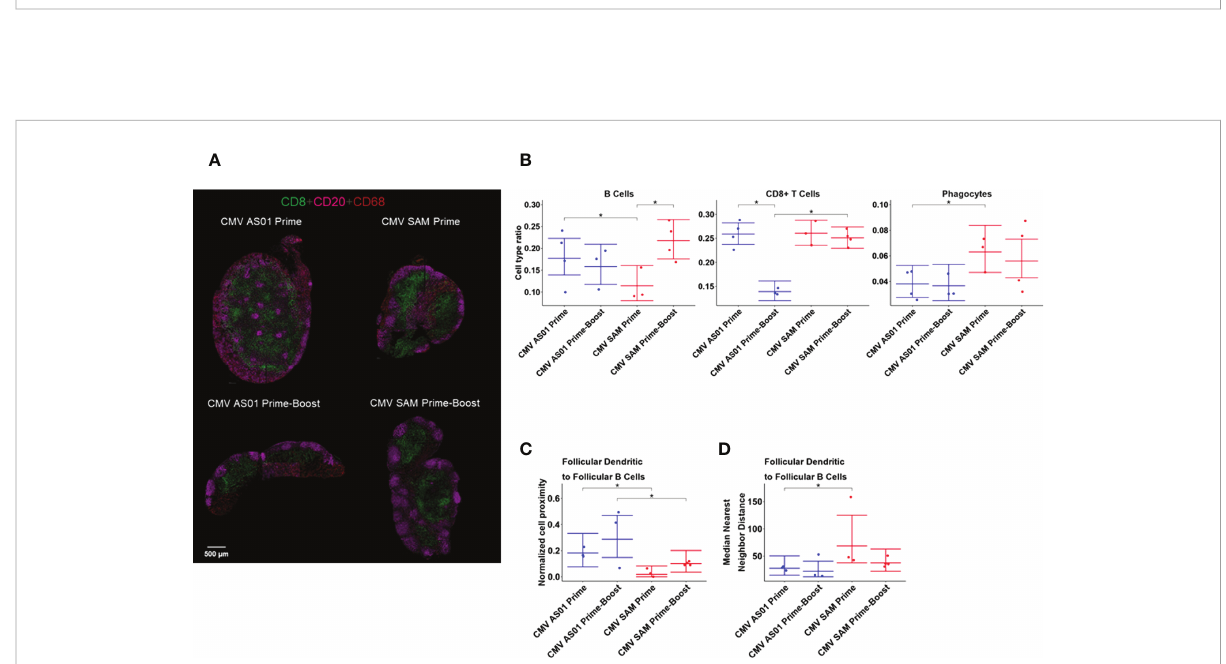
FIGURE 6 IMC images of popliteal lymph nodes and immune cell interaction analysis. Representative IMC images of CD8, CD20, and CD68 from CMV AS01 Prime, CMV SAM Prime, CMV AS01 Prime-Boost, and CMV SAM Prime-Boost lymph nodes (A) . The cell type ratio comparisons between treatments for three cell populations: B cells, CD8+ T cells, and Phagocytes (B) . The normalized cell proximity describes the average number of follicular B cells near to each follicular dendritic cell in a given rat (C) . The nearest neighbor distance is the distance between a follicular dendritic cell and the closest follicular B cell and is presented as the median of those distances, summarized per rat (D) . Data are presented as the mean and the 95% CI. *P<0.05 between respective groups.